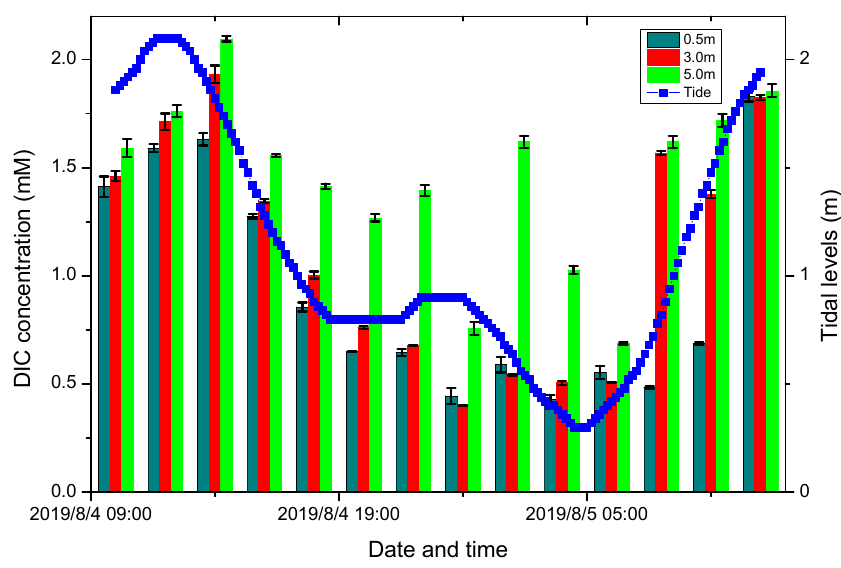
Figure 9. Observations of DIC samples at different water depth .